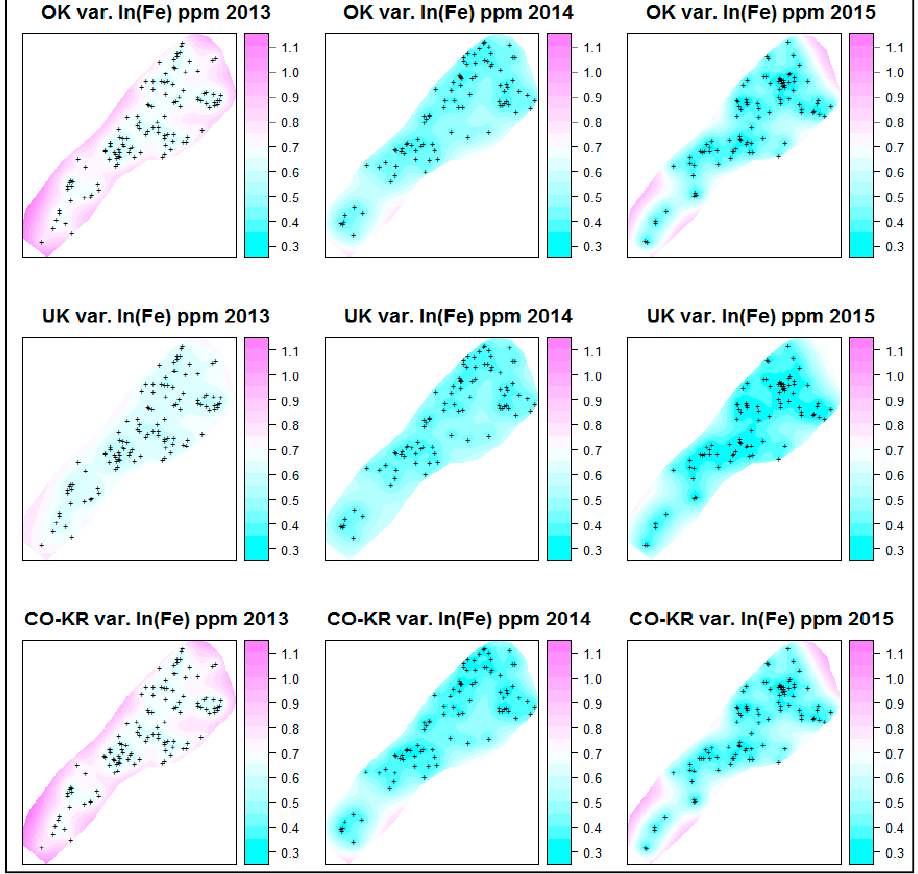
Figure 9. Prediction error maps of ln(Fe) for each year.